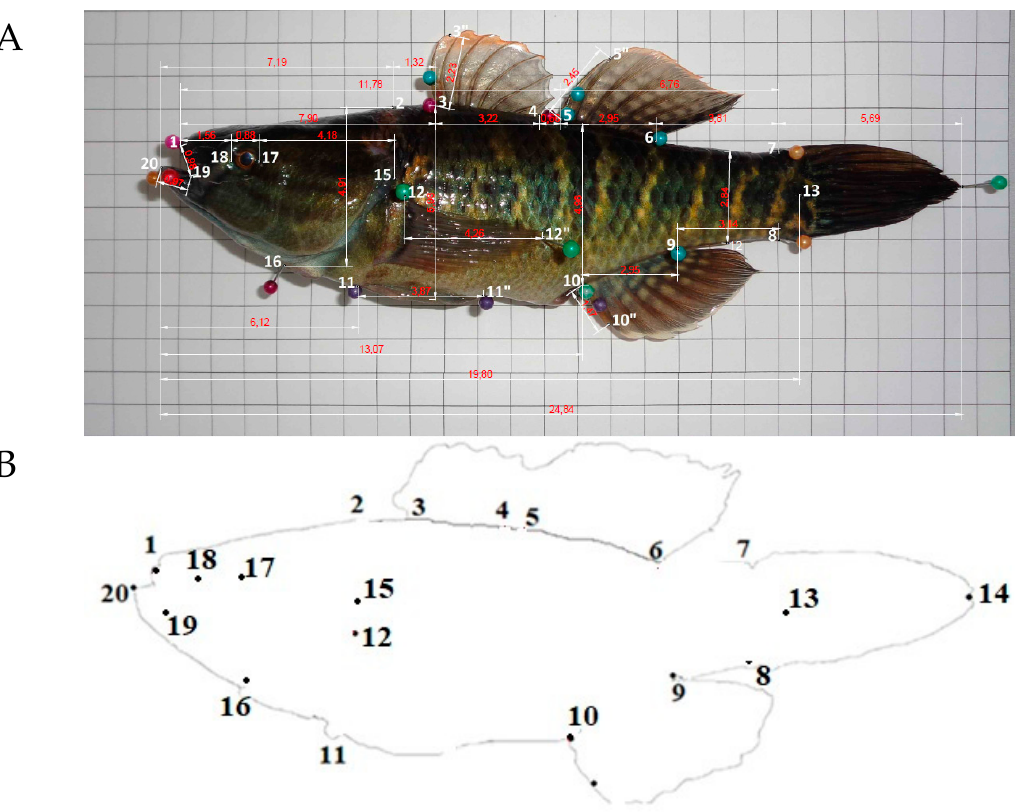
Figure 1. ( A ) The morphometric measurement records for each analyzed organism (source: own elaboration) and ( B ) the location of 20 anatomical landmark points 1 designed based on the left view of the Dormitator latrifrons . 1: most cranial point of the upper premaxilla; 2: nape, most caudal point of head; 3: origin of dorsal_1 fin; 4: ending of dorsal_1 fin; 5: origin of dorsal_2 fin; 6: ending